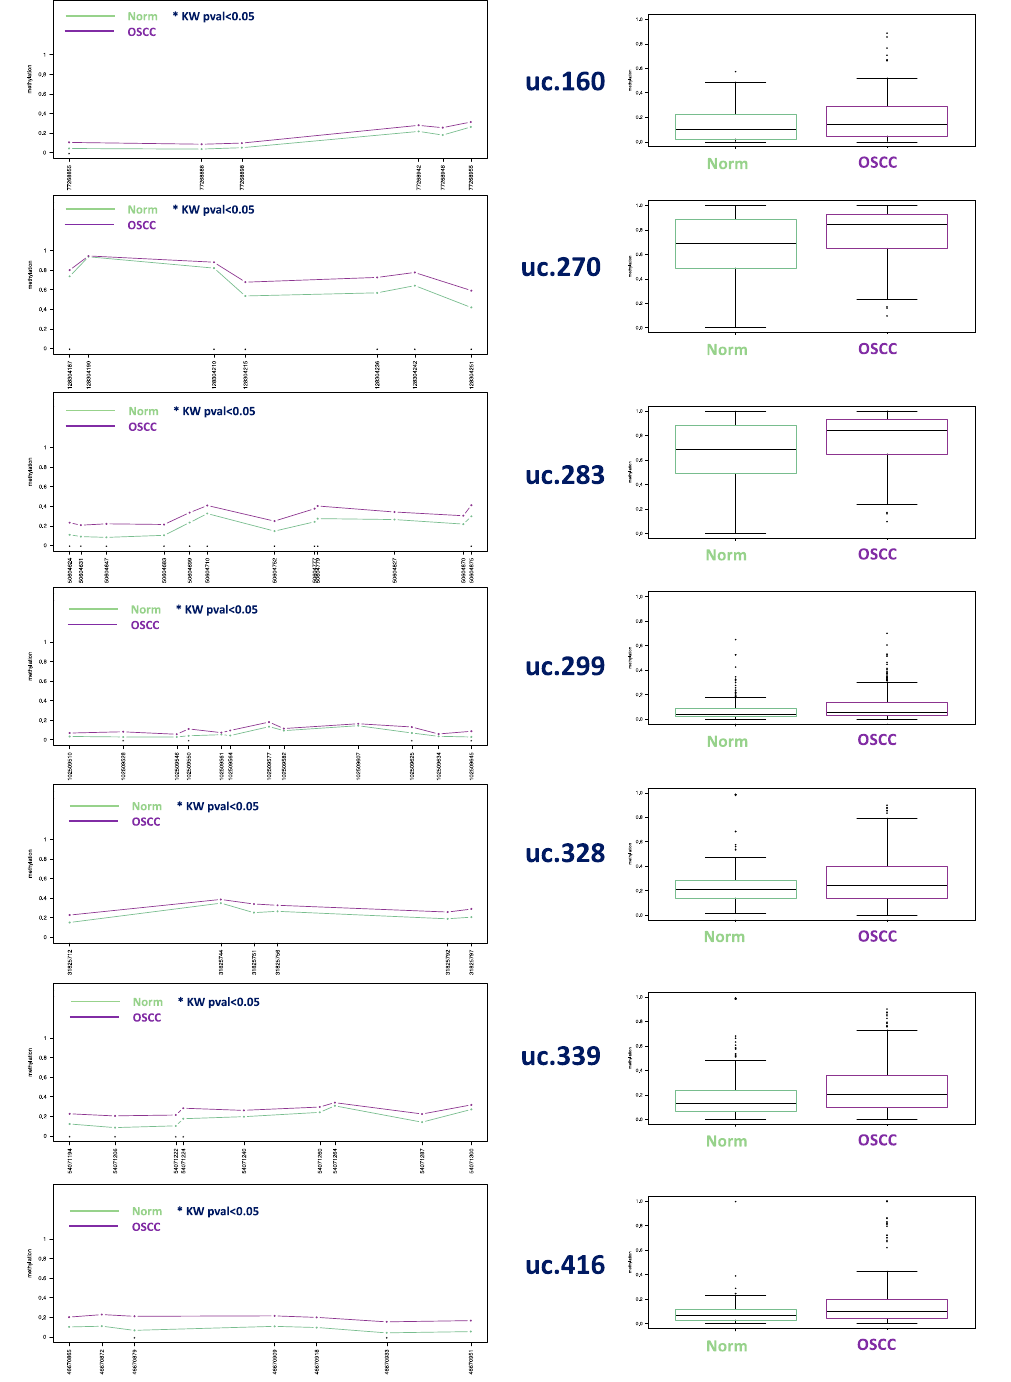
Figure 2. (Left column ): methylation plot comparing 42 normal donors with 26 SCCs from human samples: statistically significant Kruskal–Wallis test CpG are the following positions: uc.160: CpG 77268855 p < 0.01; uc.270: CpG 128304187 p = 0.029, CpG 128304210 p = 0.016, CpG 128304251 p = 0.012, CpG 128304215, 128304236, and 128304242 p < 0.01; uc.283: all CpGs * with p < 0.01 except for CpG 50604631 ( p = 0.016), 50604699 ( p = 0.026), and 50604710 ( p = 0.042); uc.299: CpG 102509528 and 102509625 showed p < 0.01, while p = 0.044 was found for CpG 102509550 and p = 0.024 for 102509645; uc.339: all CpG with * showed p < 0.01 except for CpG 54071224 ( p = 0.017); uc.416: CpG 46670879 p < 0.01, CpG 46670933 p = 0.026. ( Right column ): boxplot for each group of samples considering all the CpGs evaluated (see Supplementary Table S2 for details).